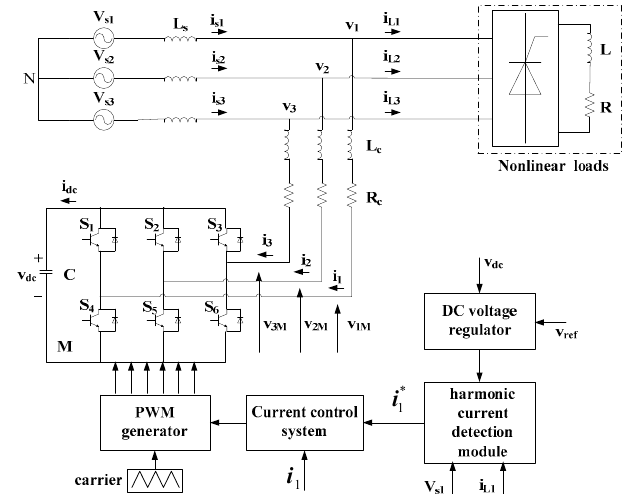
Figure 1. Block diagram of active power filter (APF).